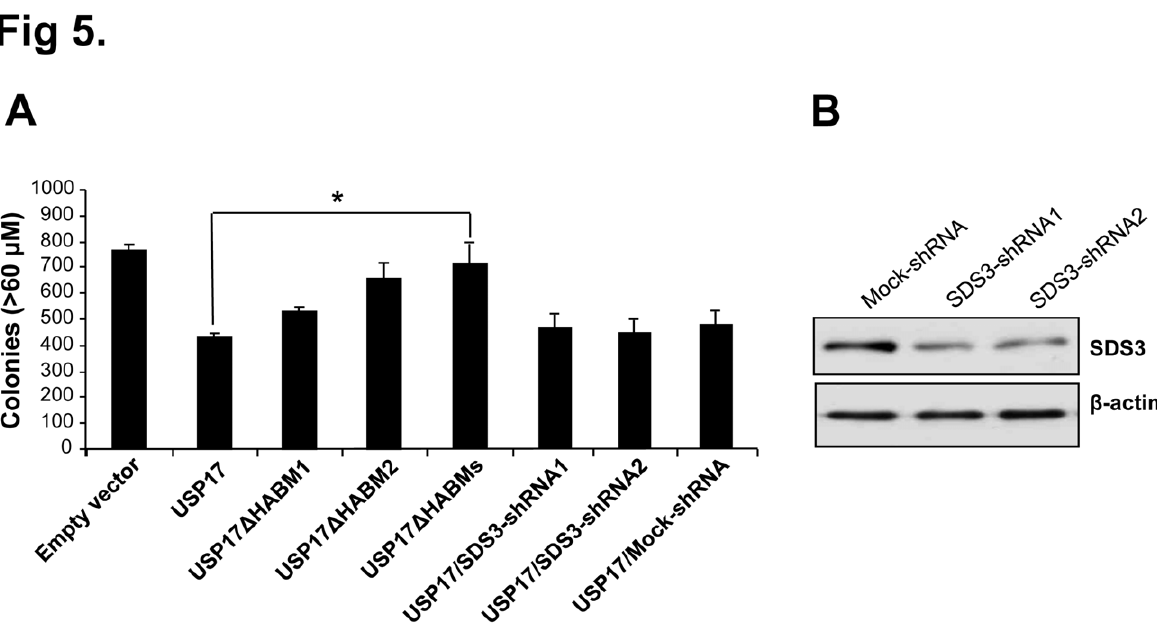
Figure 5. Anti-tumor activity of USP17 and SDS3 containing HABMs. A ) HeLa cells transfected with empty vector, USP17, USP17 D HABM1, USP17 D HABM2, USP17 D HABMs, USP17/SDS3-shRNA1, USP17/SDS3-shRNA2 and USP17/Mock-shRNA were plated, in triplicate. After 14 days, the colonies were stained and numbers were determined by counting colonies from soft agar assay. A mean of triplicate measurements; bars, Standard deviation, n=3. *, p , 0.05. B ) The knockdown efficiency of SDS3-shRNA1 and shRNA2 were checked by Western blot analysis in HeLa cells. C ) HeLa cells transfected with empty vector, SDS3, SDS3 D HABMs, SDS3/USP17-shRNA1, SDS3/USP17-shRNA2, and SDS3/Mock-shRNA were plated, in triplicate. A mean of triplicate measurements; bars, Standard deviation, n=3. *, p , 0.05. D ) The knockdown efficiency of USP17-shRNA1 and shRNA2 were checked by Western blot analysis in HeLa cells. E ) HeLa cells transfected with empty vector, USP17, SDS3, USP17/SDS3, and USP17 D HABMs/ SDS3 D HABMs were plated, in triplicate. Results represent the average number of colonies formed from three individual experiments. A mean of triplicate measurements; bars, Standard deviation, n=3. *, p , 0.05. F ) HeLa cells transfected with respective constructs and cell proliferation was assessed by Cell Counting Kit-8 assay. Mean standard deviation of a triplicate experiment is shown. G ) HeLa cells expressing respective constructs were harvested and stained with annexin V and propidium iodide. The statistical representation of the percentage of apoptosis was recorded. The results represent the mean (n =3) of a representative experiment. Error bars represent standard error of the mean. *, p , 0.05. H ) HeLa cells transfected with respective constructs were checked for HABMs-mediated migratory effect of USP17 or SDS3 by wound healing assays. Percentage of migration was statistically analyzed from three separate experiments. n =3. *, p , 0.05.